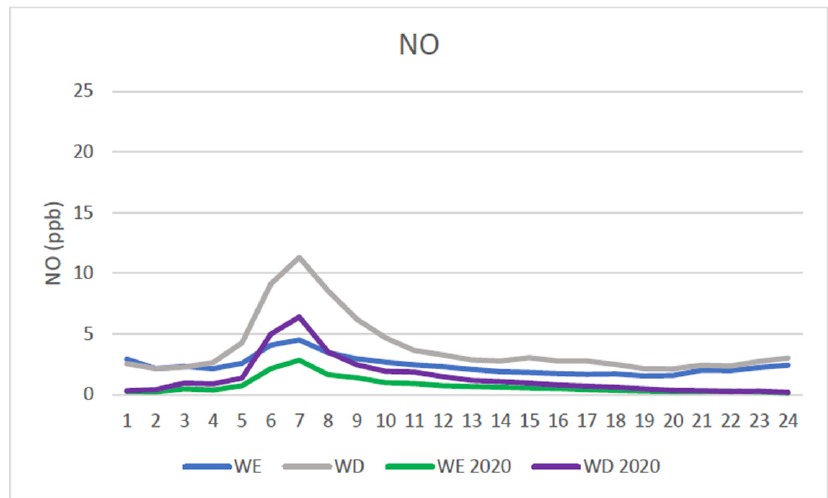
Figure 5. Nitrous oxide (NO) for the average period April to June 2010–2019 for weekends (WE) and weekdays (WD) and for April to June 2020 (WE 2020, WD 2020) at Toronto East.